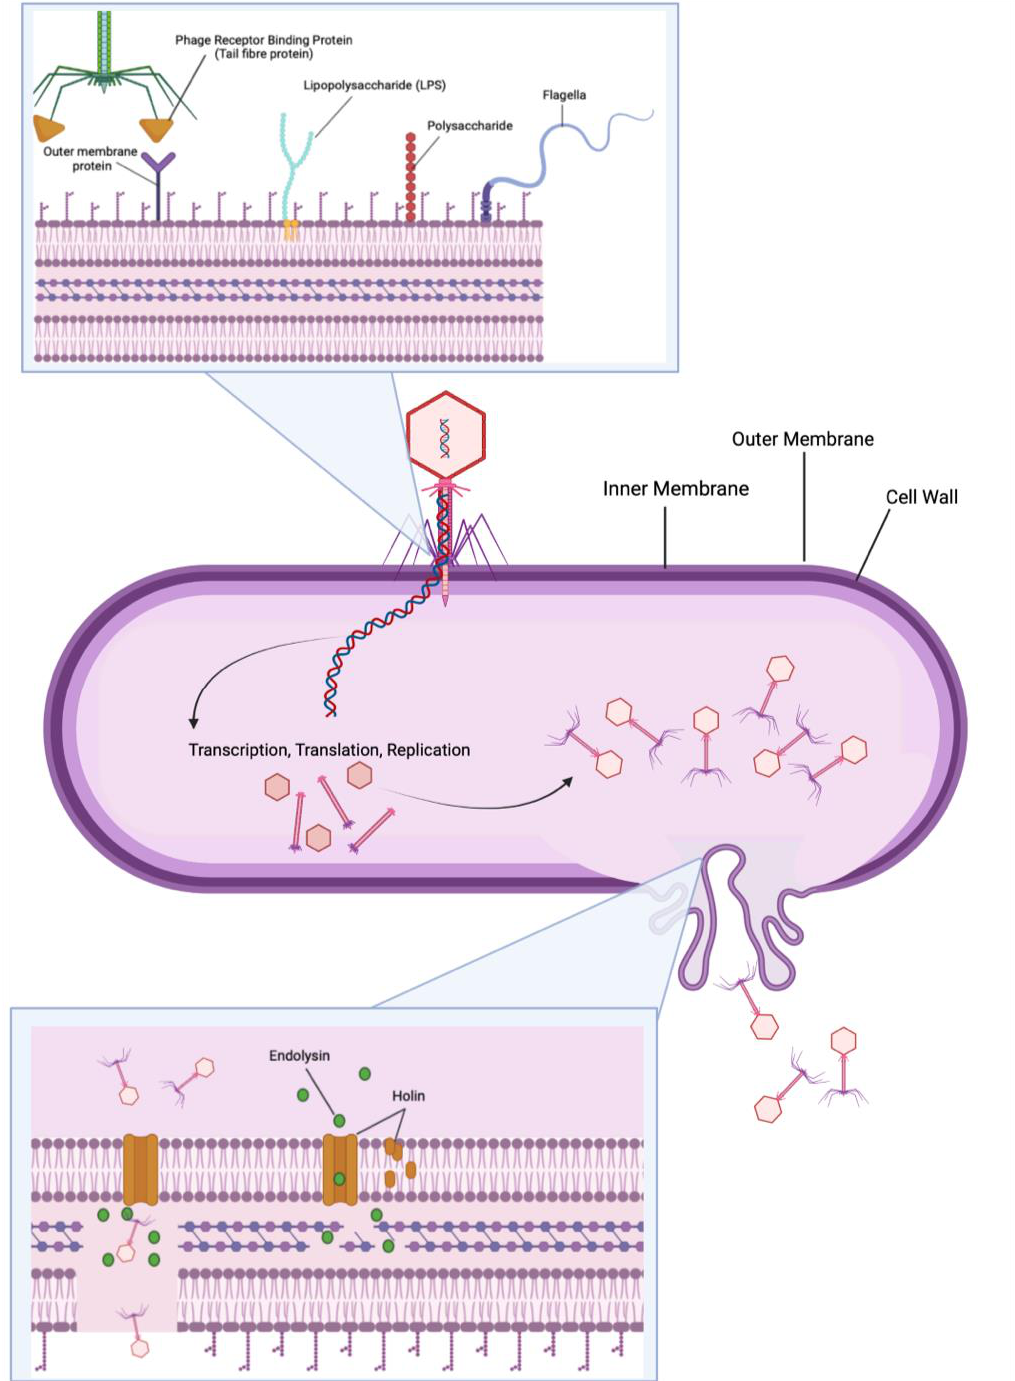
Figure 1. Bacteriophage adsorption, replication, and release of phage progeny. Attachment of